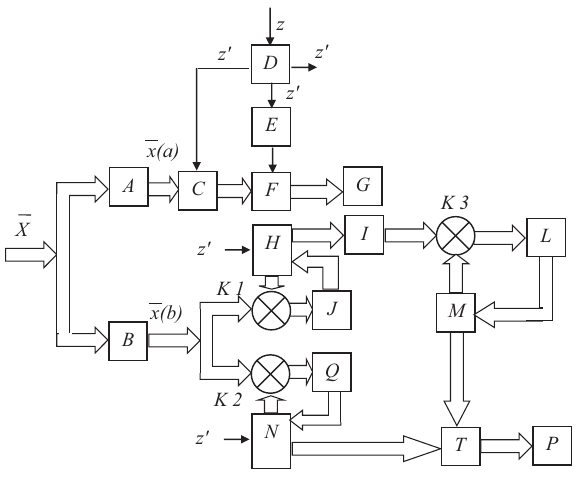
Figure 3 . Diagram of forming output signal y i ( b ′ ). Figure 4 . Diagram of NE detector learning ‘ with teacher ’